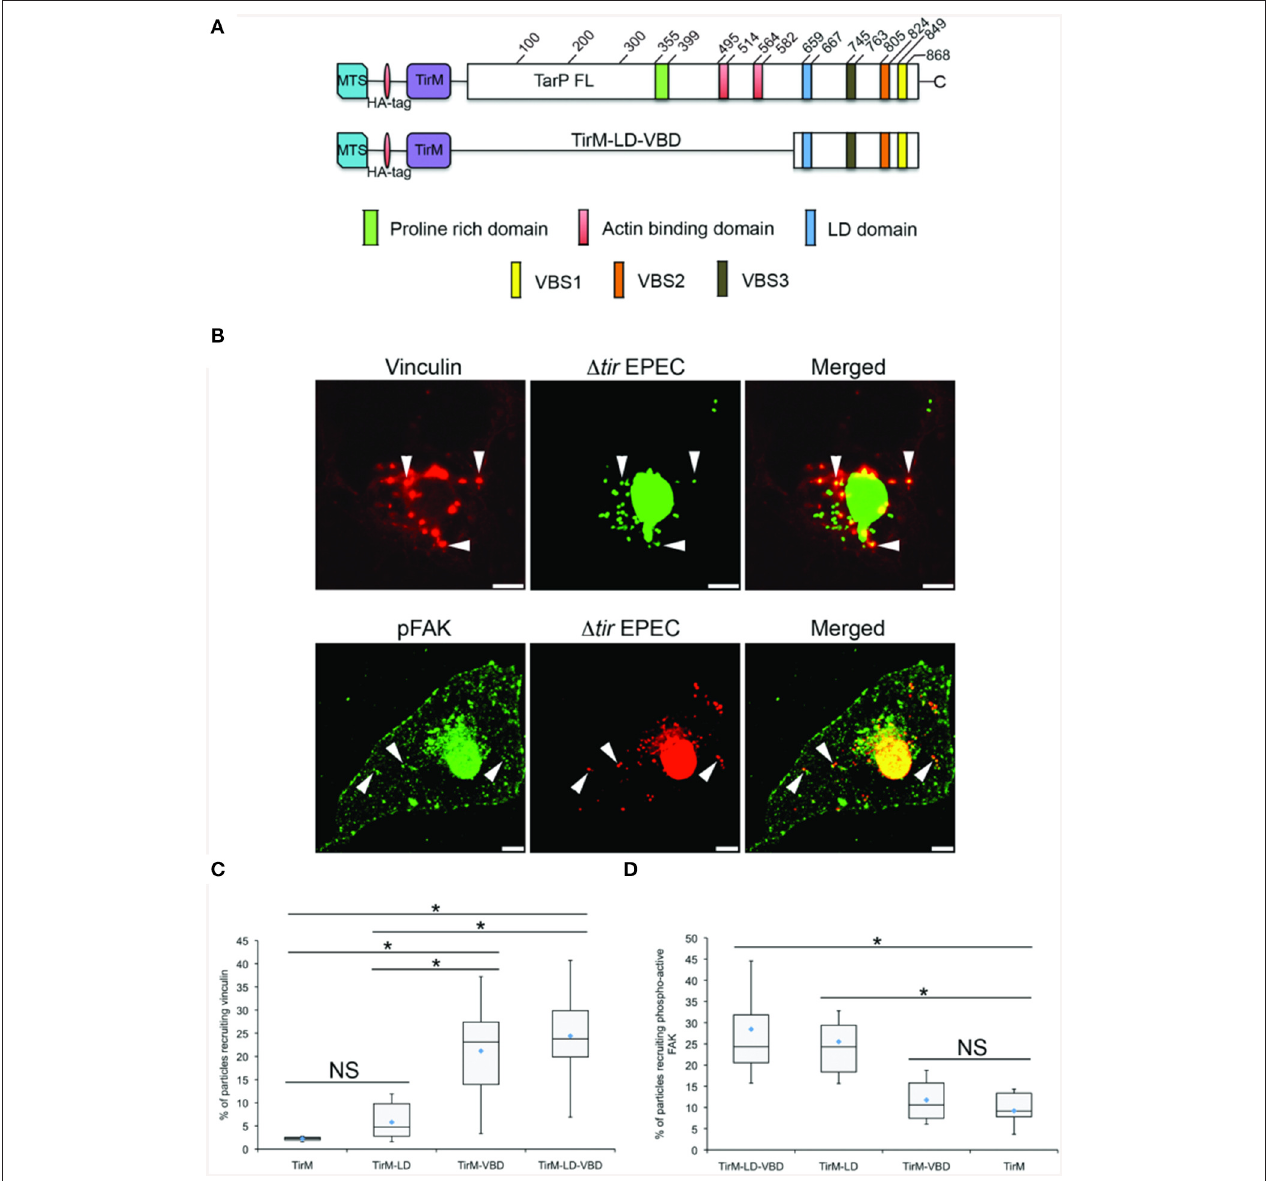
FIGURE 8 | The LD-VBD protein is functional and able to recruit phospho-active or vinculin. (A) Schematic of full length TarP (TarP-FL) or its derivative, the LD-VBD, which represents a combination of the TarP LD domain and the TarP Vinculin Binding Domain (VBD). Please see Figure 4 legend for details. (A,B) Cos7 cells transfected with the plasmid encoding LD-VBD were infected with 1 tir EPEC to induce clustering of the proteins. Transfected cells were identified by the capacity to facilitate bacteria attachment. The white arrowheads indicate colocalization of phospho-active FAK (pFAK) or vinculin with adhered 1 tir EPEC. pFAK (green) and vinculin (red) were visualized with an anti-FAK (phospho Y397) or an anti-vinculin antibody, respectively. Bacteria [false-colored green (vinculin) or red (pFAK)] were visualized by DAPI. Scale bars: 10 µ m. (C,D) Adhered EPEC able to recruit vinculin (C) or pFAK (D) were enumerated and data represented as box and whisker plot. Data compiled from two independent experiments. Plot shows range (statistical outliers excluded), first and third quartiles, and overall median (horizontal line). Diamonds show means. Roughly 200 particles were counted for both conditions. The asterisk and bars indicate significance difference between specific groups (One-way ANOVA, Tukey’s post-hoc test, P < 0.00001 ). NS; not significant. For comparison, previously quantified data for the LD domain alone or the VBD domain alone with pFAK or vinculin was